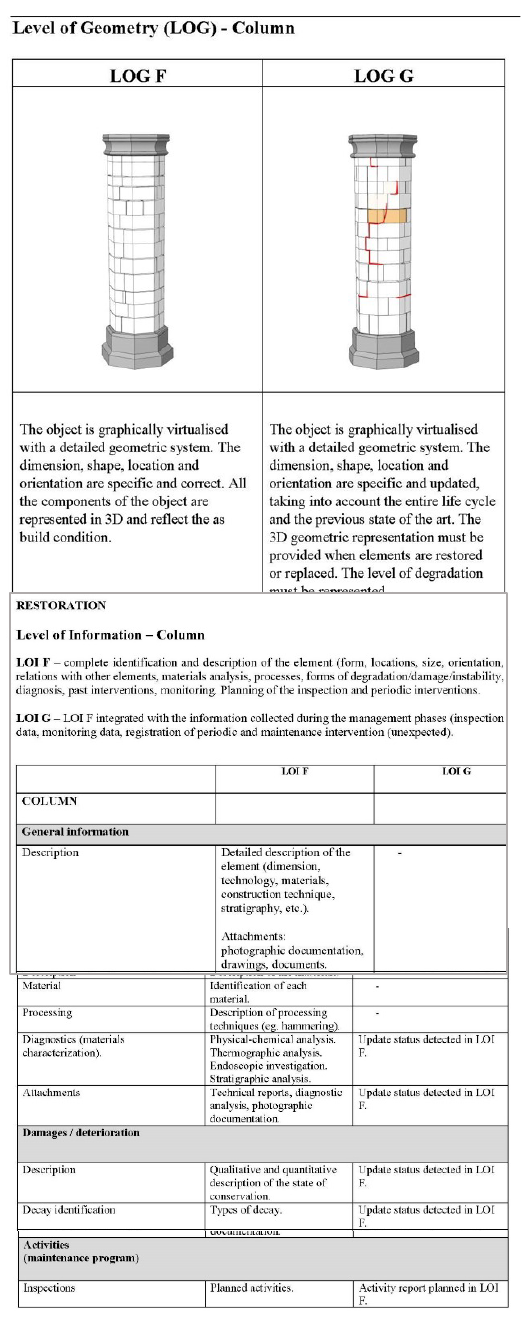
Figure 12. UNI 11337-3-2017 draft of the proposed LoG-LoI (‘F and G’)